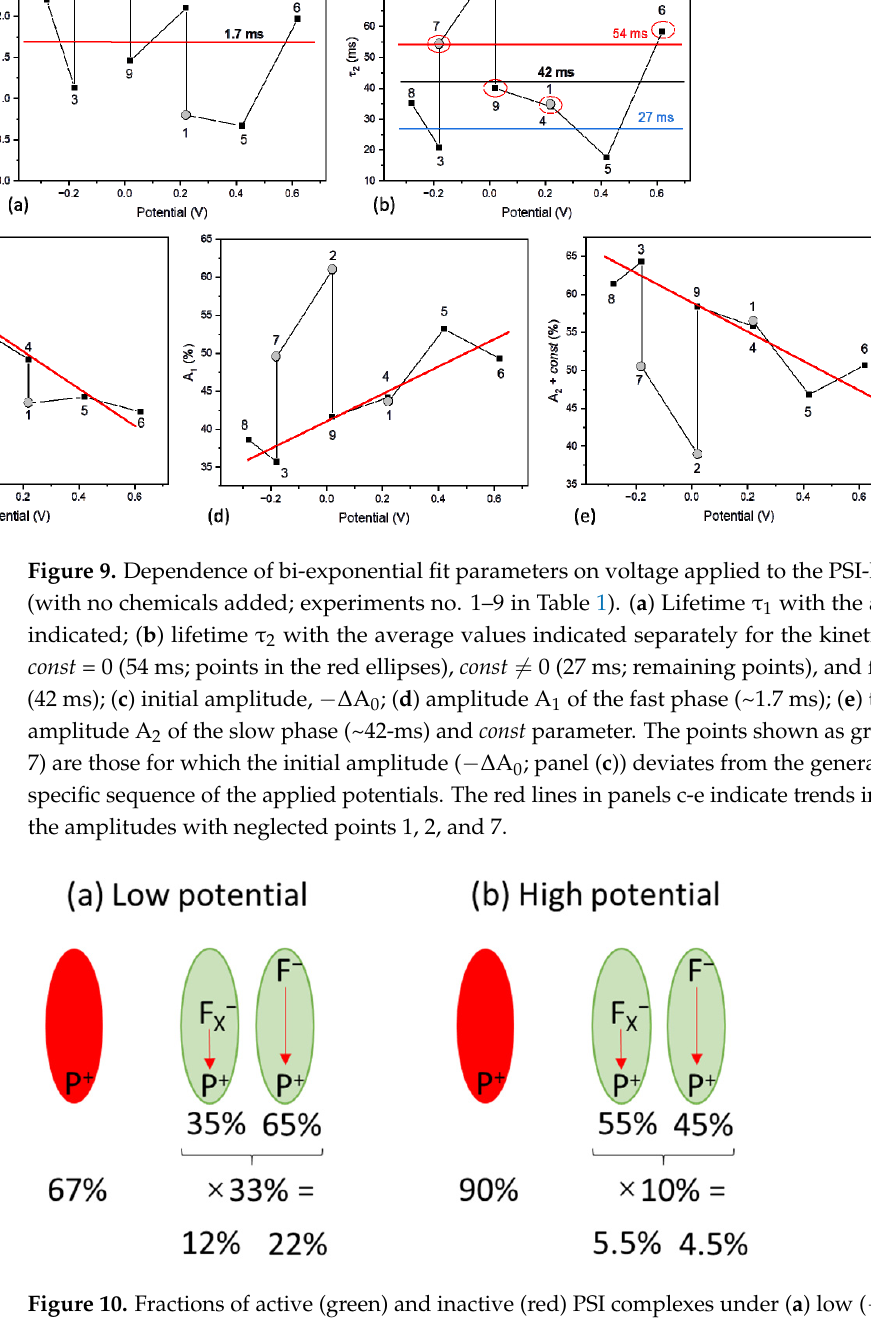
Figure 10. Fractions of active (green) and inactive (red) PSI complexes under ( a ) low ( − 280 mV) and ( b ) high (+620 mV) potential. Within active PSI complexes, fractions recombining from the states P + F X − and P + F A/B − are shown.